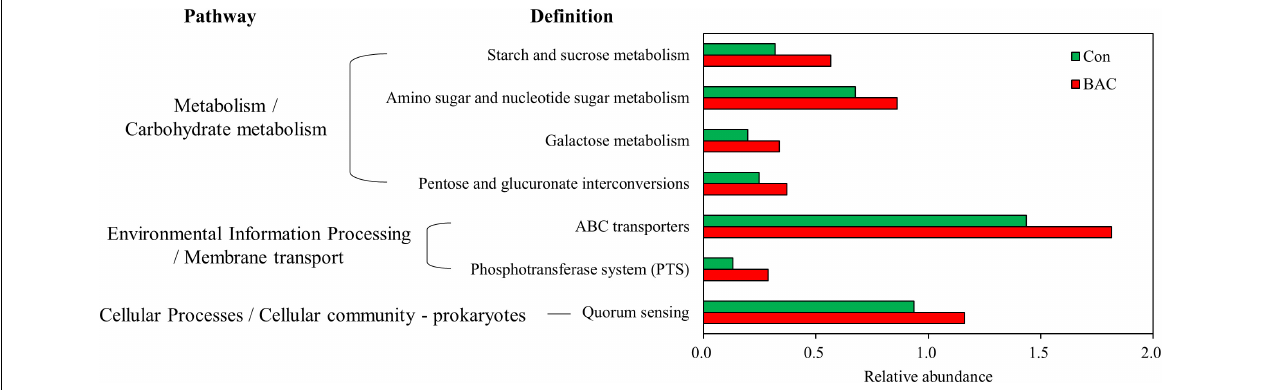
FIGURE 5 | Presumptive metabolism functions of microbiota in A. japonica with different diets. Kyoto Encyclopedia of Genes and Genomes (KEGG) pathway was obtained from 16S metagenomic sequences using